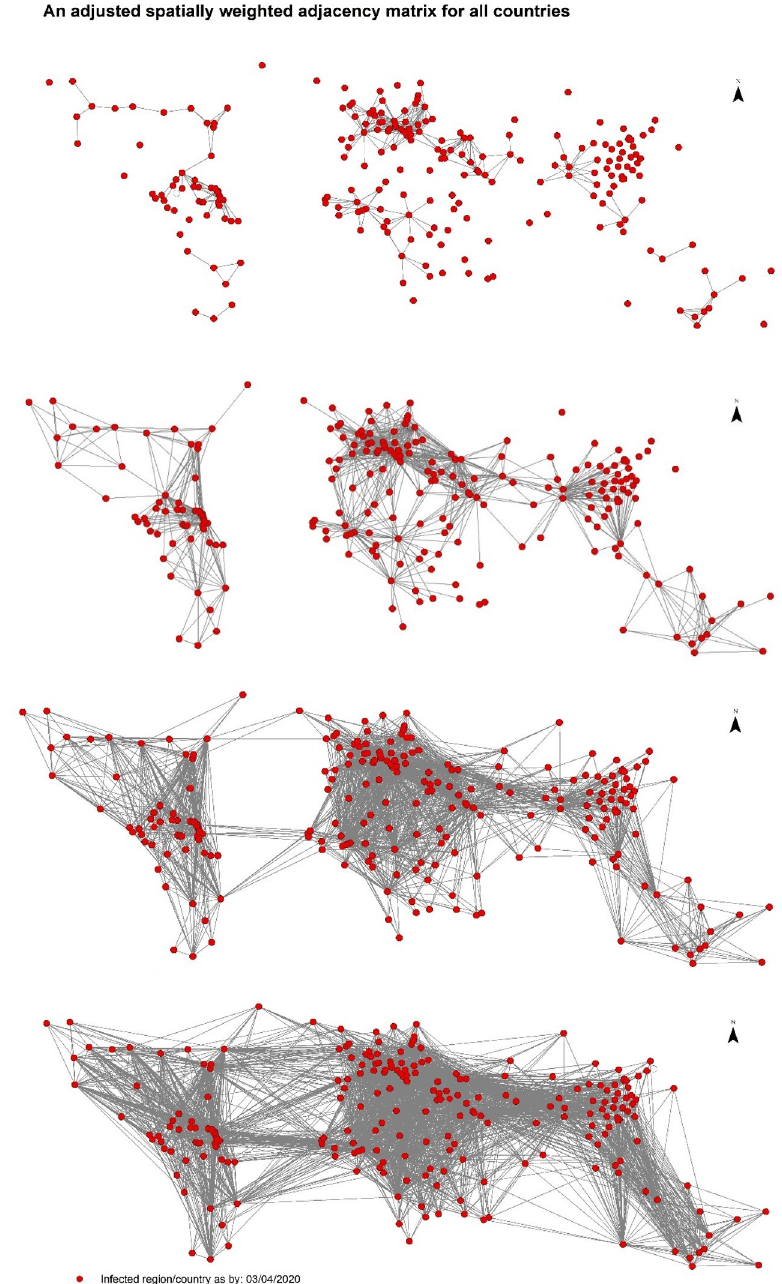
Fig 8. Few examples of different adjusted spatially weighted adjacency matrix, conditioned by limiting direct connection that would be generated by VAE after initialisation. global level, with a fraction difference between the actual and predicted ones on the last exam- ined day 14/06/2020. Specifically, Fig 10A show the accumulated prediction and the actual cases globally in a linear scale of cases counts. Fig 10B shows the true and predicted of con- firmed cases at a logarithmic scale. It compares the logarithmic prediction and true values. After the initial days- where the initial cases were mainly zero in many countries globally and